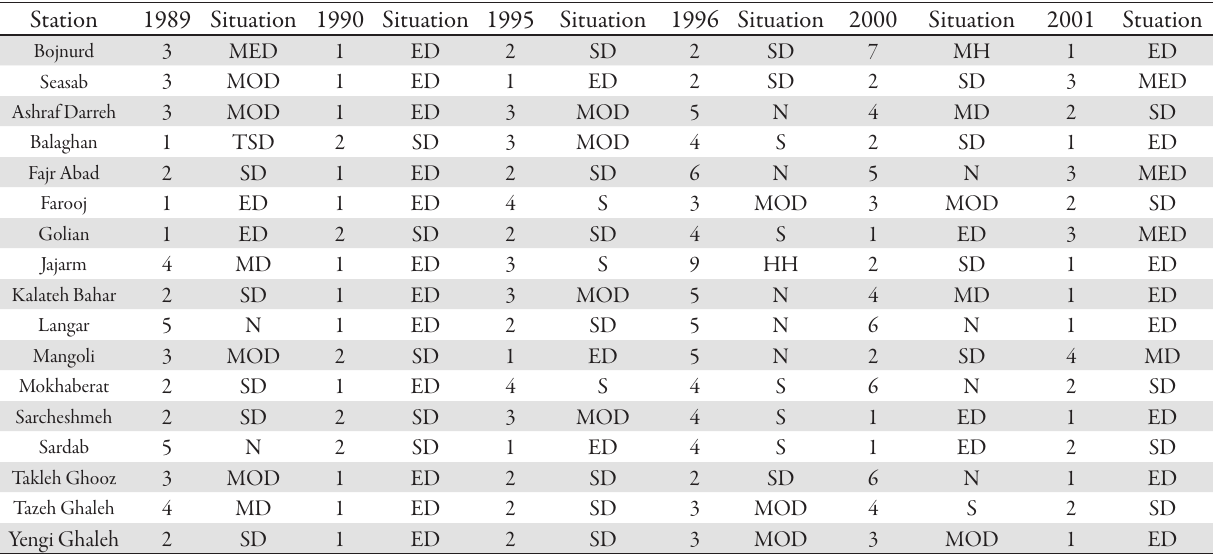
Tab. 4. Values and situations of drought occurrence across Northern Khorasan province by Decades Index Station 1989 Situation 1990 Situation 1995 Situation 1996 Situation